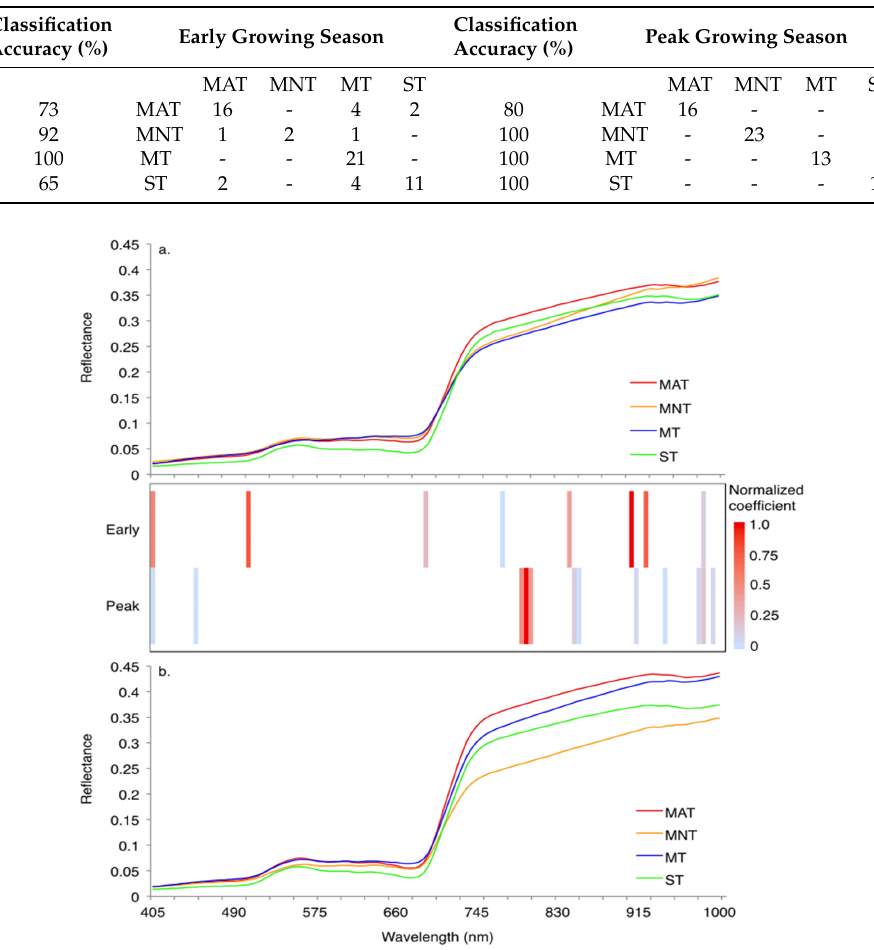
Table 4. Confusion matrices and classification accuracies at Ivotuk, Alaska using the top ten percent of significant hyperspectral narrowbands (HNBs).